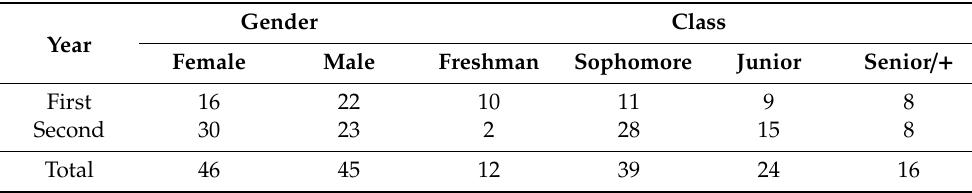
Table 2. Student demographic data by